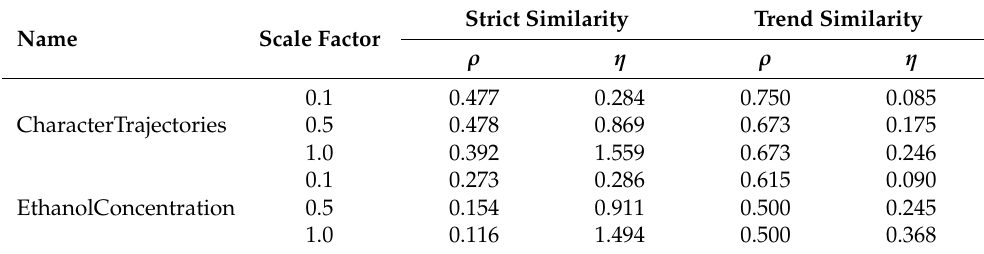
Table 5. Scalability on datasets with different numbers of time